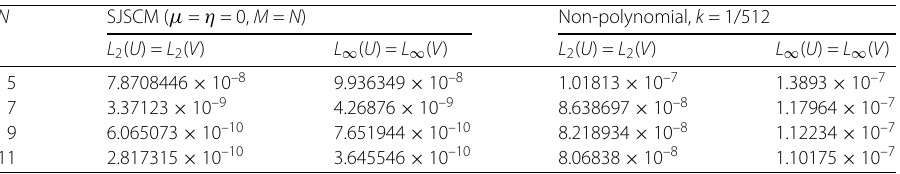
Table 8 L 2 and L ∞ error norms for u ( x , t ) = v ( x , t ) of Example 2 when 0 ≤ x ≤ 1, α 1 = α 2 =